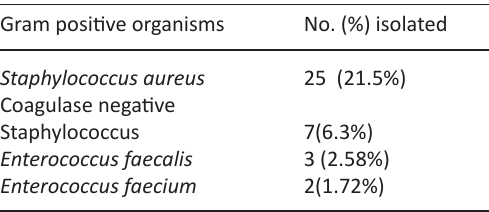
Table 2. Total number of gram positive isolates from blood culture (n=37) Gram positive organisms